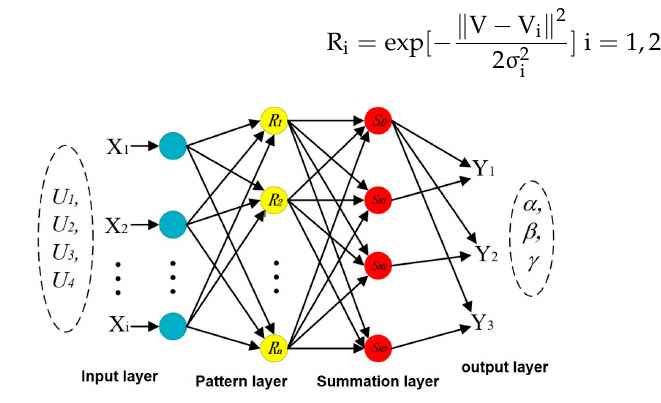
Figure 4. Generalized regression neural network .